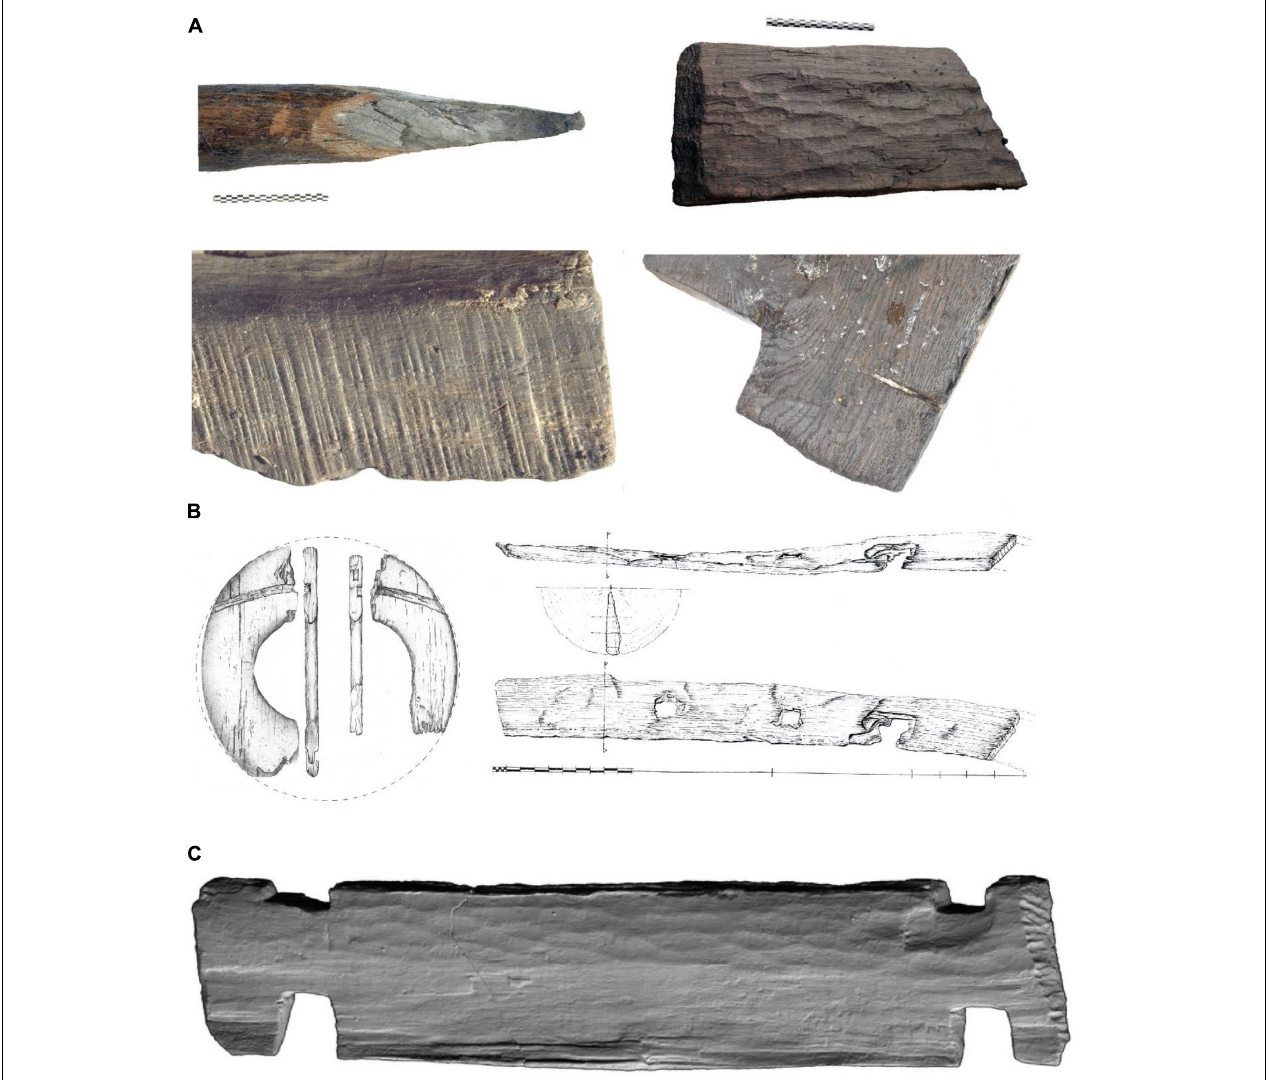
FIGURE 4 | Examples of the documentation of archaeological waterlogged wood (Rybníˇcek et al., 2018) by (A) photos of tool marks from slashing tools (axes, adzes) and saws, (B) drawings (Tegel and Croutsch, 2016), and (C) laser scan (Tegel et al.,